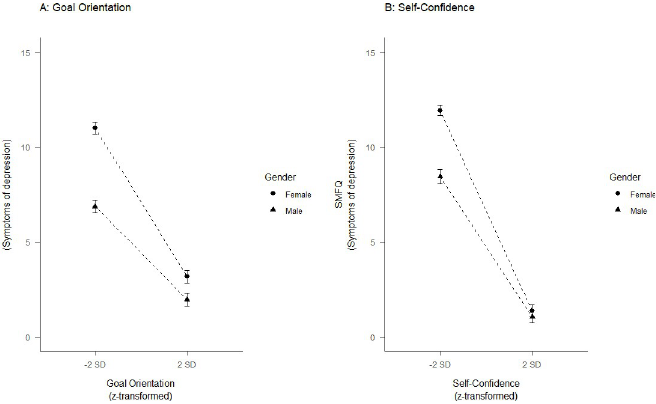
Fig 3. The association between symptoms of depression and (A) Goal Orientation and (B) Self-Confidence for girls and boys. SMFQ: short moods and feelings questionnaire, SD: standard deviation. Error bars represent 95% confidence